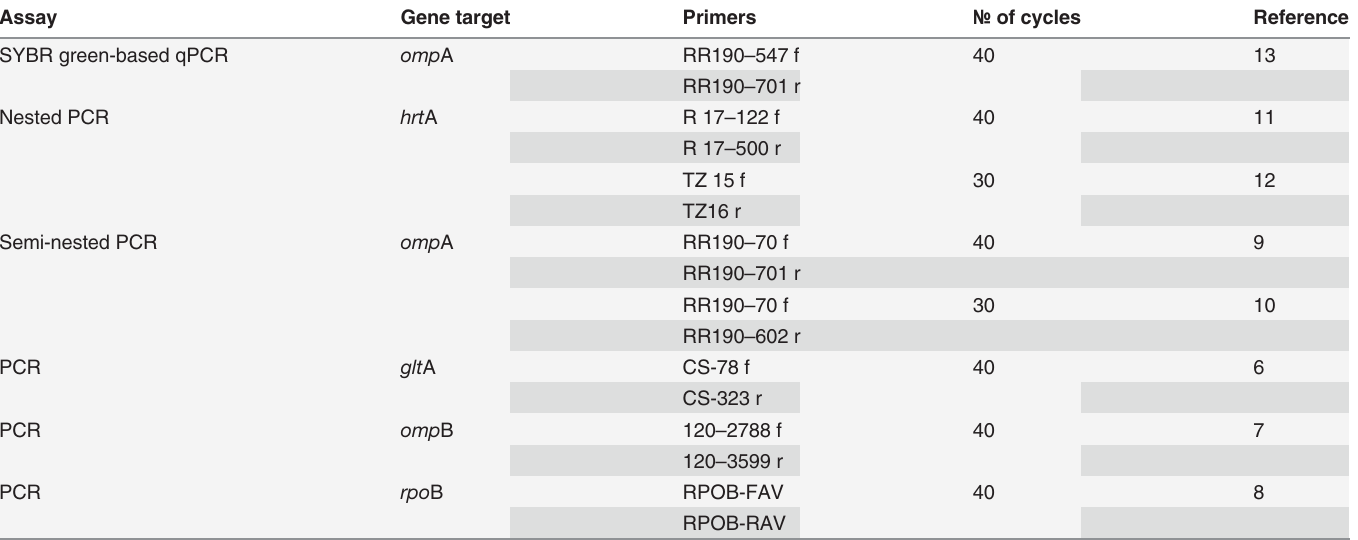
Table 1. List of assays and primer pairs used for comparison analysis.